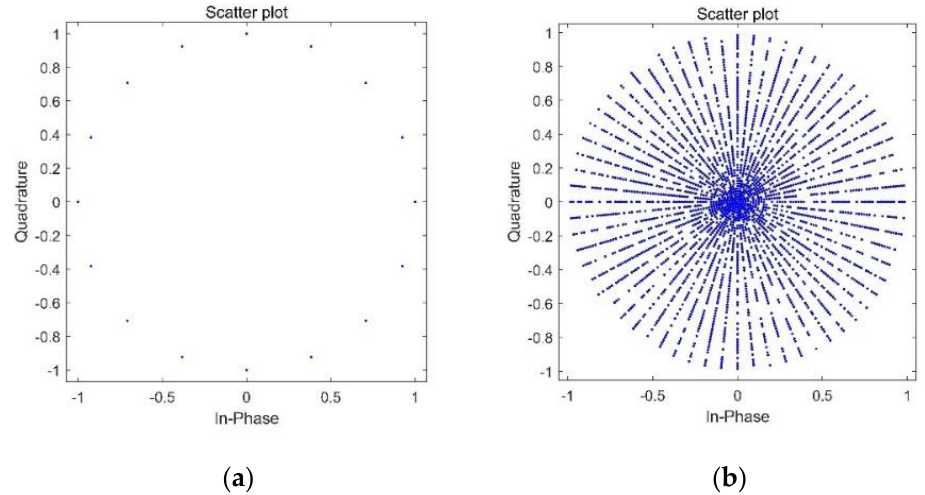
Figure 8. BPSK constellation encryption algorithm. ( a ) Phase rotation and ( b ) rotation and ampli- tude adjustment.